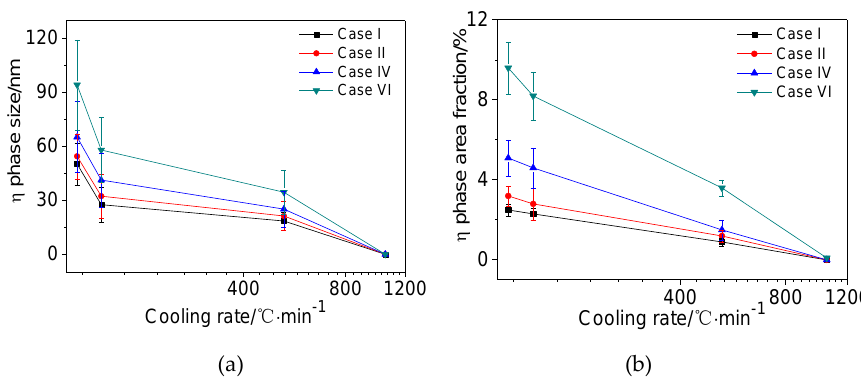
Figure 5. Relationship of ( a ) the size of η phase vs. cooling rate and ( b ) the area fraction of η phase vs. cooling rate.